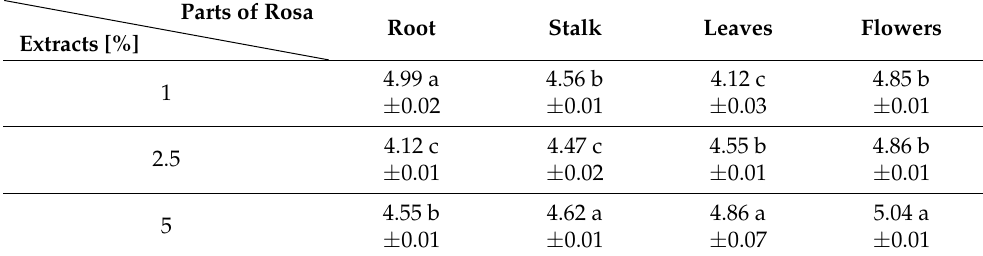
Table 5. PH values of aqueous organ extracts Rosa blanda Aiton; the mean values of the five replicates ( ± SD) marked with different letters differ significantly (in column) according to Duncan’s test p ≤ 0.05. Extracts